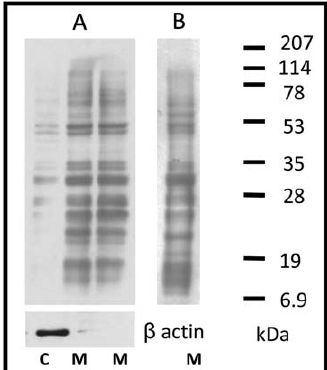
Figure 2. Far Western Blot with cytosolic (C) and membrane proteins (M). Fifteen m g of proteins from cytosol and membrane fractions were blotted after electrophoresis. Far Western Blot was performed with A) 100 ng/ml of untagged A b 1–42 enriched in oligomers. Actin is shown as a marker for the cytosolic fraction. B) 100 ng/ml of EDANS-tagged A b 1–42 enriched in